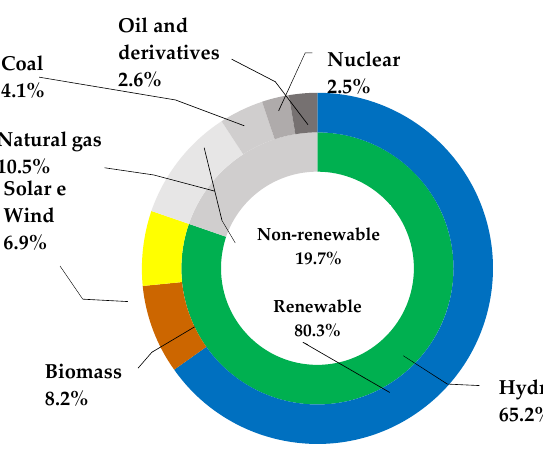
Figure 5. Brazil’s electric energy matrix [11]. Figure 5. Brazil's electric energy matrix [11].